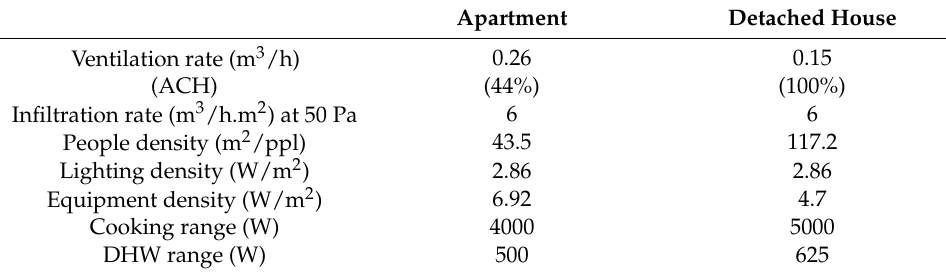
Table 2. Internal loads of the prototypical buildings [24].